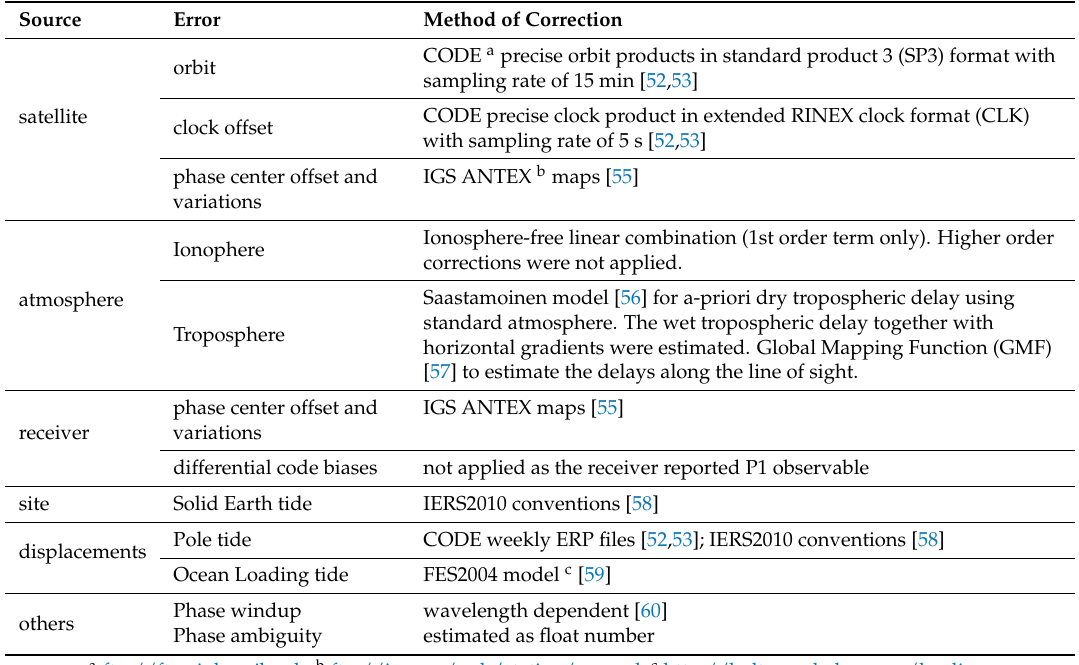
Table 2. Methods of correction for various observation errors in our PPP data processing